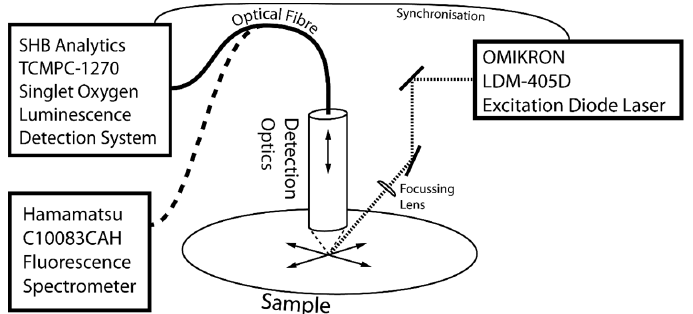
Figure 8 . Scheme of 1 O 2 scanning setup. Figure 8. Scheme of 1 O